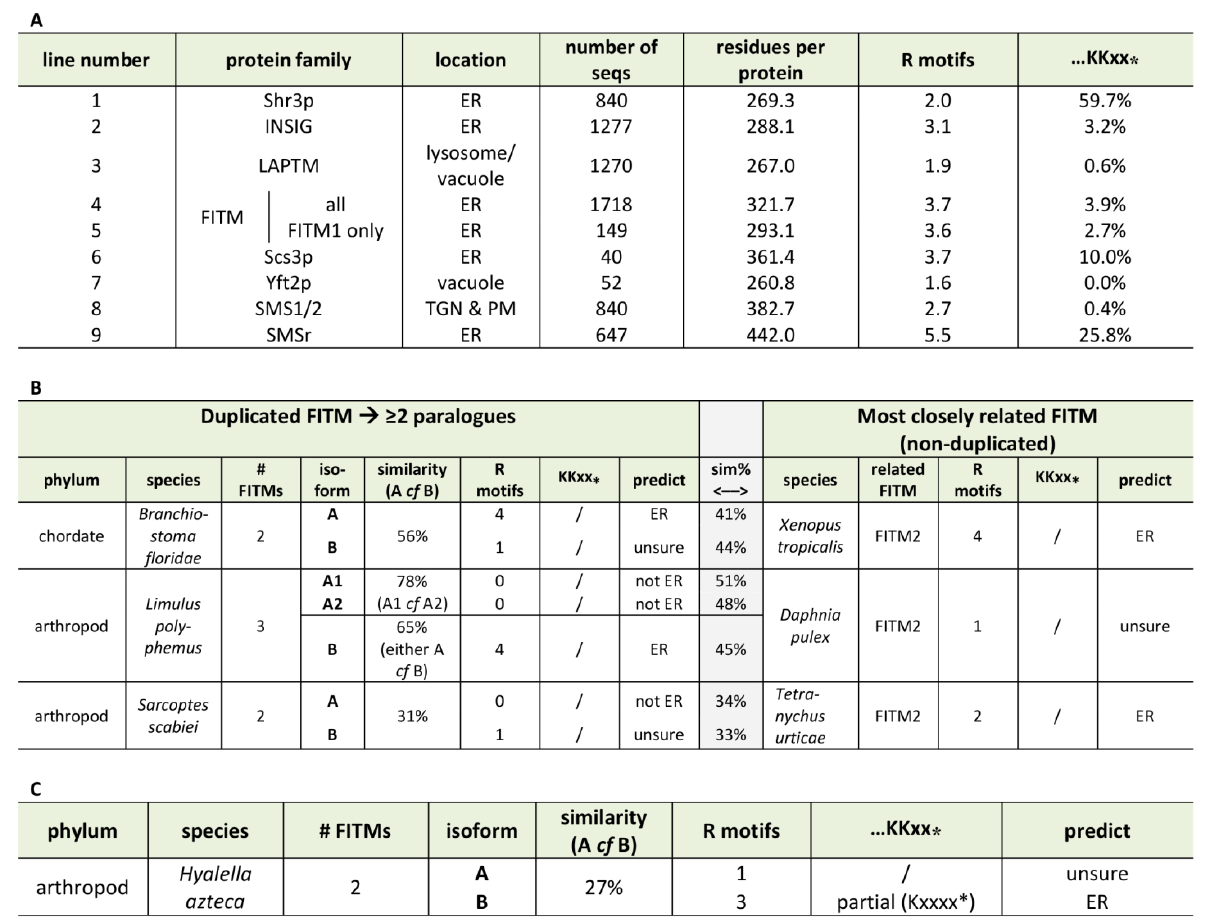
Table 1. ER retention motifs in FITM